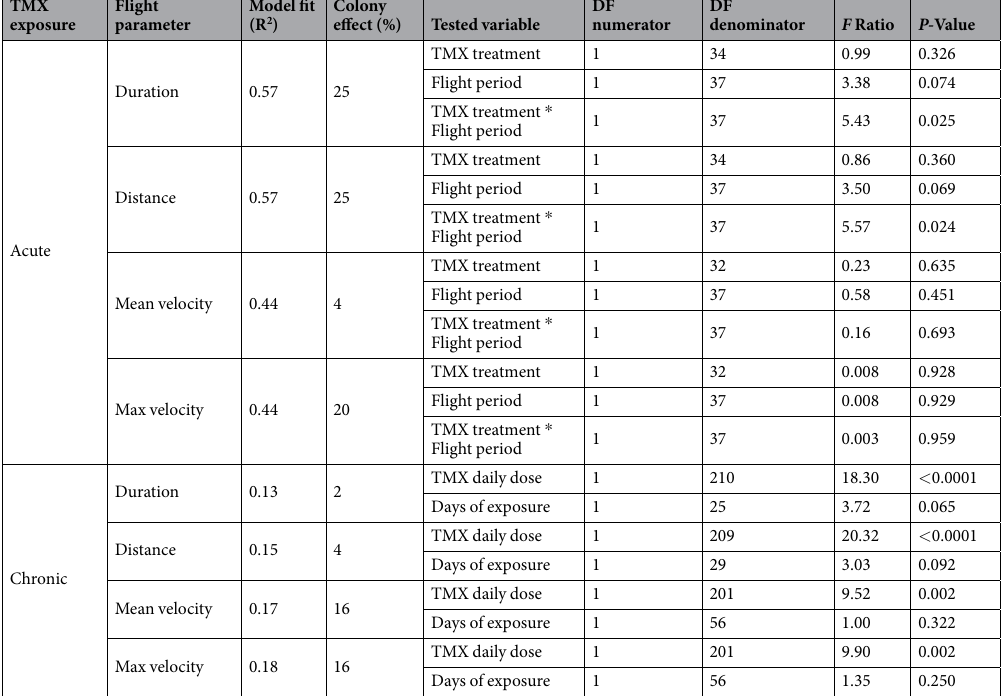
Table 1. Summary of the statistical results of the acute and chronic experiments. REML variance component estimates of colony effects are reported as percentages (acute exposure: repeated-measures ANOVA REML ; chronic exposure: Mixed Model REML , based on N TMX daily doses = 46). N control group, before = 16, N control group, after = 16,